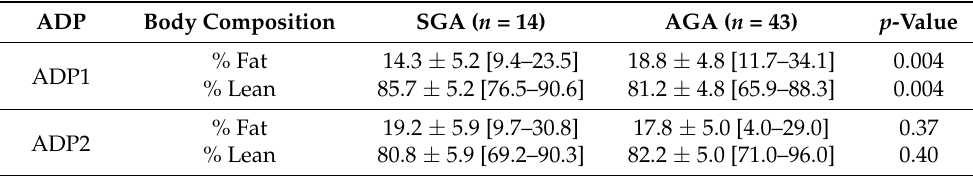
Table 3. Body composition of SGA and AGA over time ( n = 57).